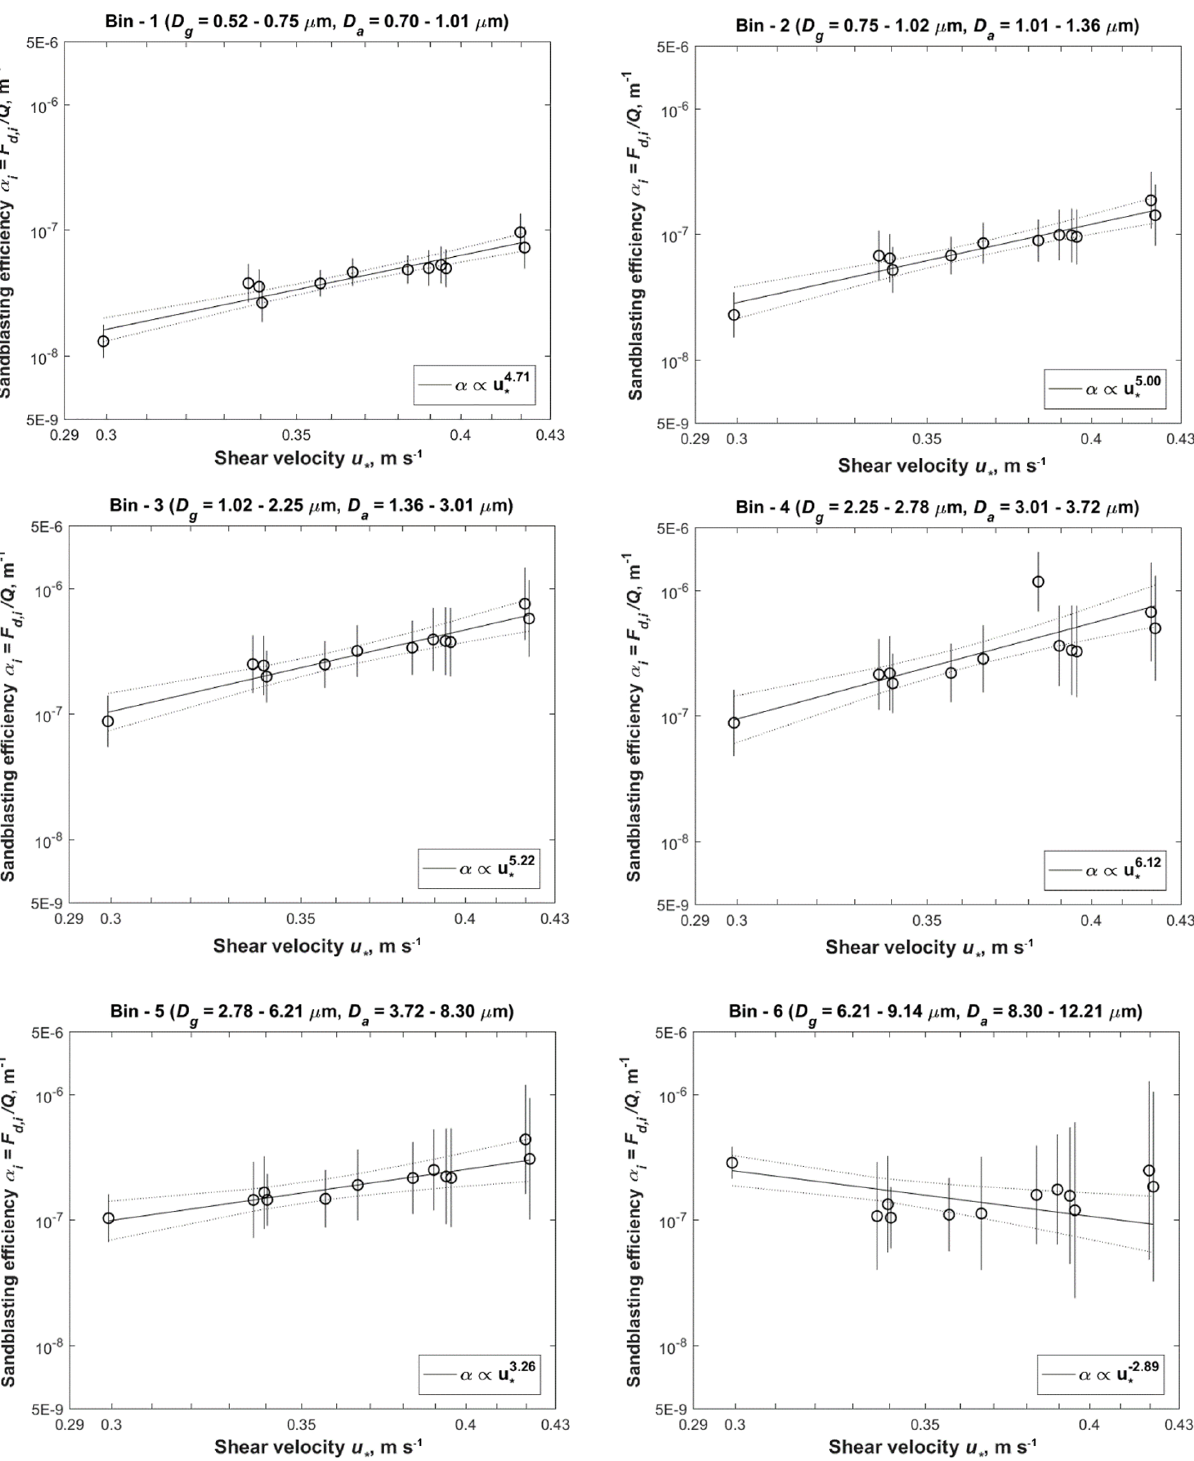
Figure 6. The sandblasting efficiency α i (m − 1 ) of the six size bins at Oceano as a function of shear velocity. The linear-least-squares fit (black line) indicates that α i varies as a power law in shear velocity with an exponent of 4 . 71 ± 0 . 97, 5 . 00 ± 1 . 37, 5 . 22 ± 1 . 63, 6 . 12 ± 2 . 11, 3 . 26 ± 1 . 90, and − 2 . 89 ± 1 . 94 for the six respective size bins. Error bars were obtained by propagating errors from the sensor intercalibration process, the regression used in the gradient method, and the subtraction of the sea-salt deposition flux (see Supplement). The two dotted black lines denote the 95% confidence range of the fit. The geometric and the aerodynamic diameter ranges of the vertical dust mass flux F d ,i are noted at the top of each of the six plots, and Q is the total horizontal sand flux integrated over all sand grain sizes (Martin et al.,